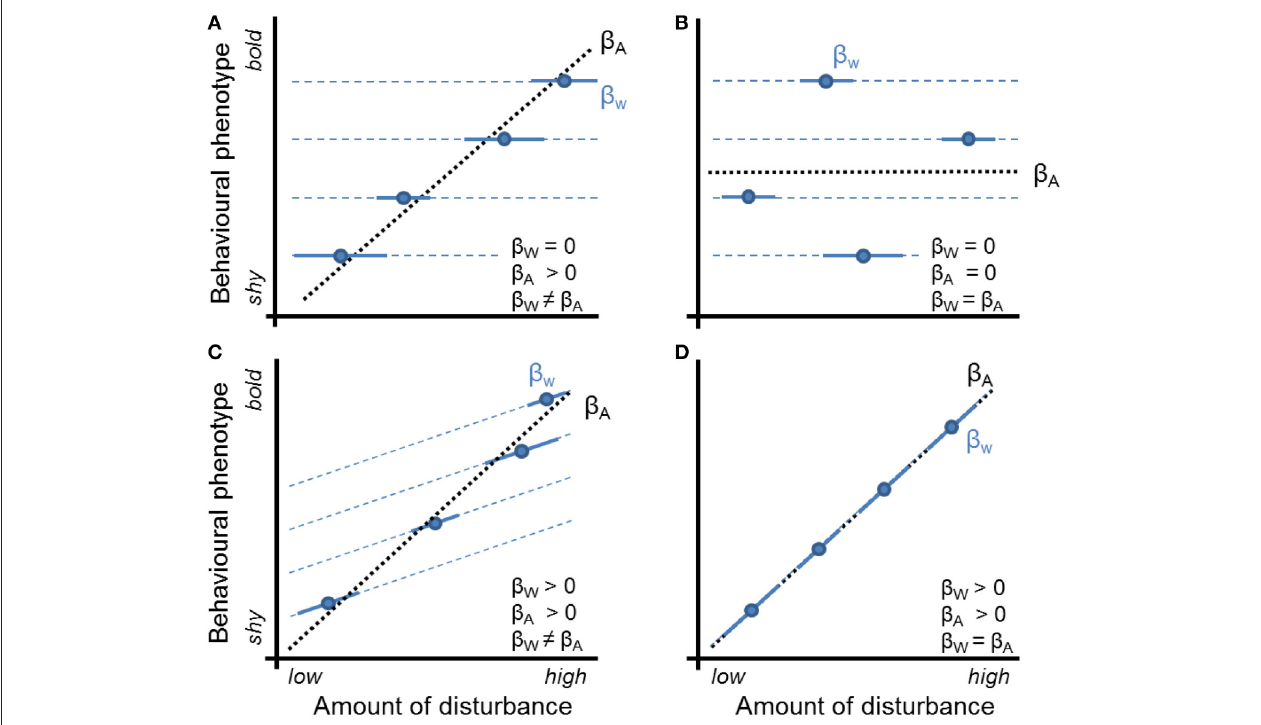
FIGURE 1 | Behavioral reaction norm plots, providing examples of possible relationships between anti-predator boldness (an exemplary behavioral phenotype) and an environmental gradient (e.g., amount of disturbance) among- vs. within-individuals. Each dot represents the average phenotype of an individual and each solid blue line represents its behavioral reaction norm over the range of environmental conditions (x-axis) that it occurred observationally. Among-individual variation in intercepts represents “personality variation” ( sensu Dingemanse et al., 2010). Non-zero slopes represent within-individual plasticity (i.e., the observed relationship between y and x within the individual: β W , blue lines). In contrast, blue dashed lines represent the hypothesized phenotype of each individual outside the range of environments in which it occurred observationally. The thick black dashed line represents the relationship between each individual’s average behavior and average environment ( β A ). Plots (A–D) show different scenarios for how behavior and the environment might be associated within and between individuals as detailed in the